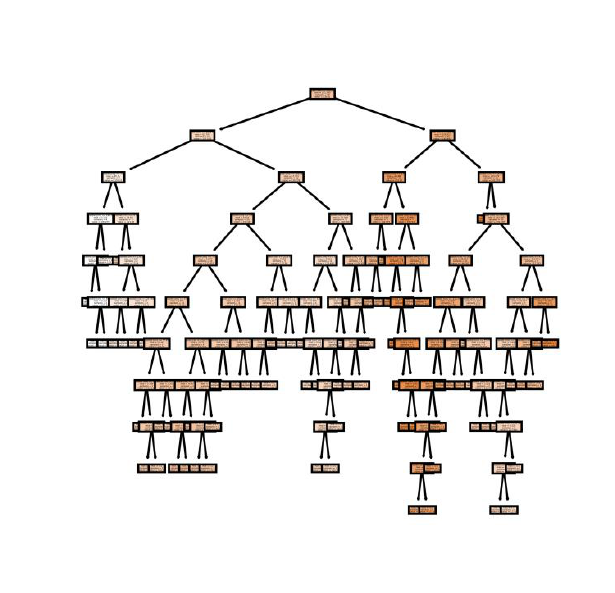
Figure 2: Implementation of Decision Tree Regression Random Forest Regression